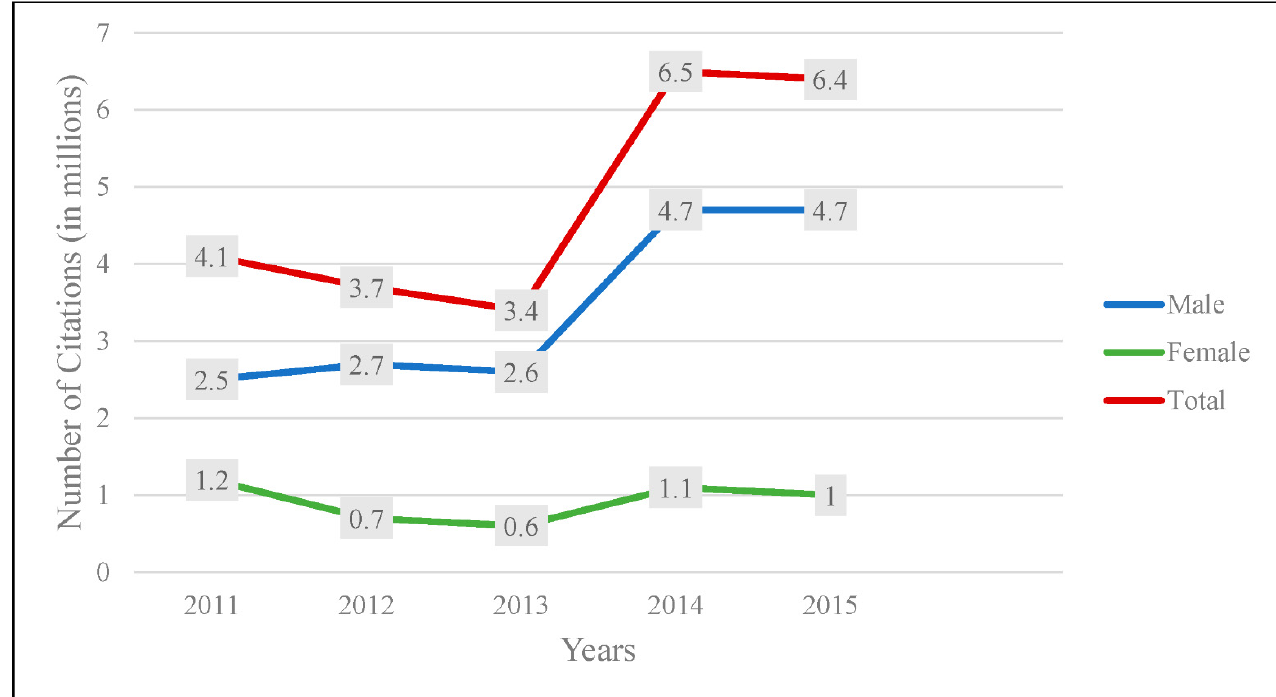
Figure 1. Total number of traffic citations by gender from 2011 to 2015.